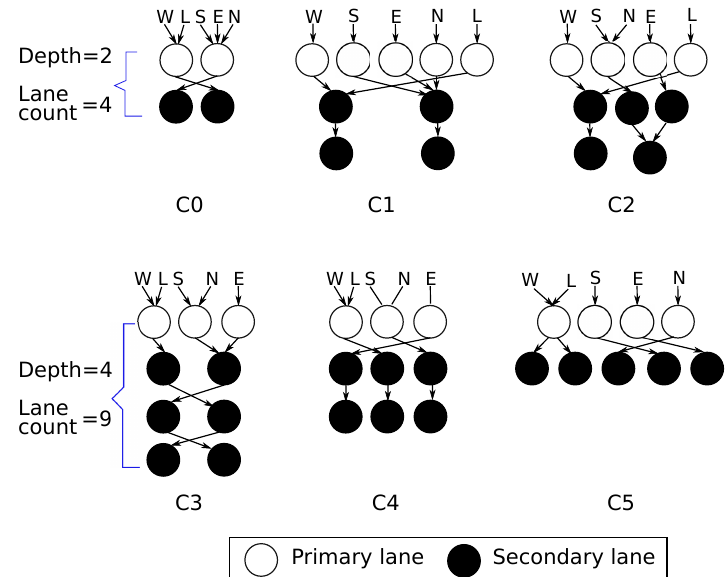
Figure 11. Considered R-NoC configurations.